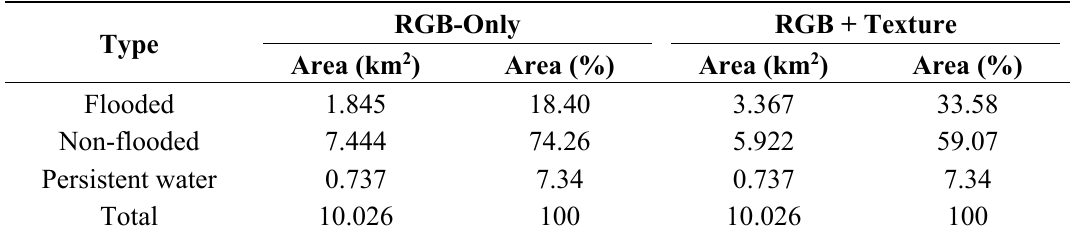
Table 1. Class statistics for RGB-only and RGB +